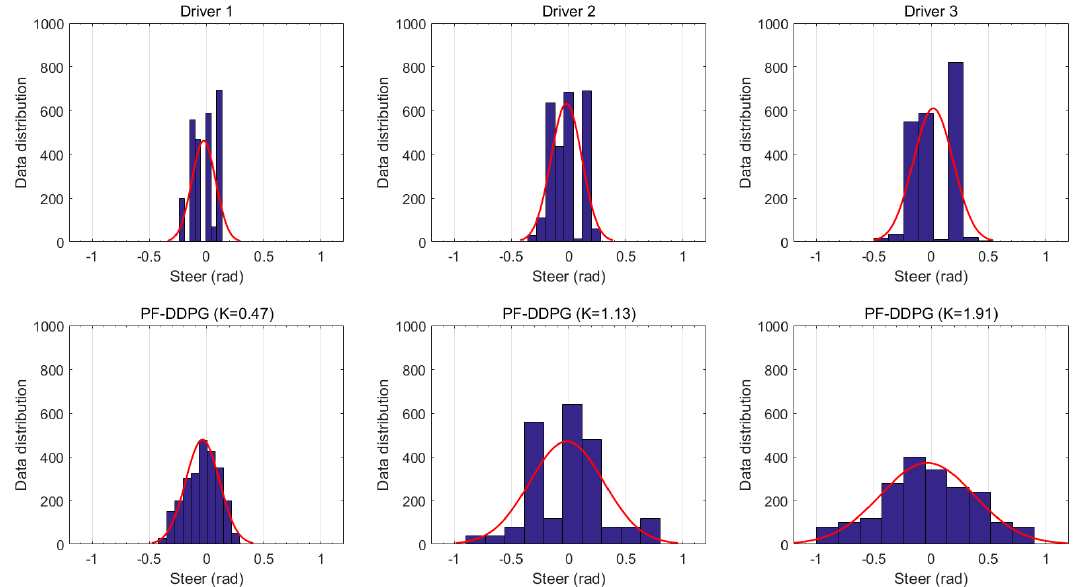
Figure 9. PF-DDPG steering action distribution compared with drivers.